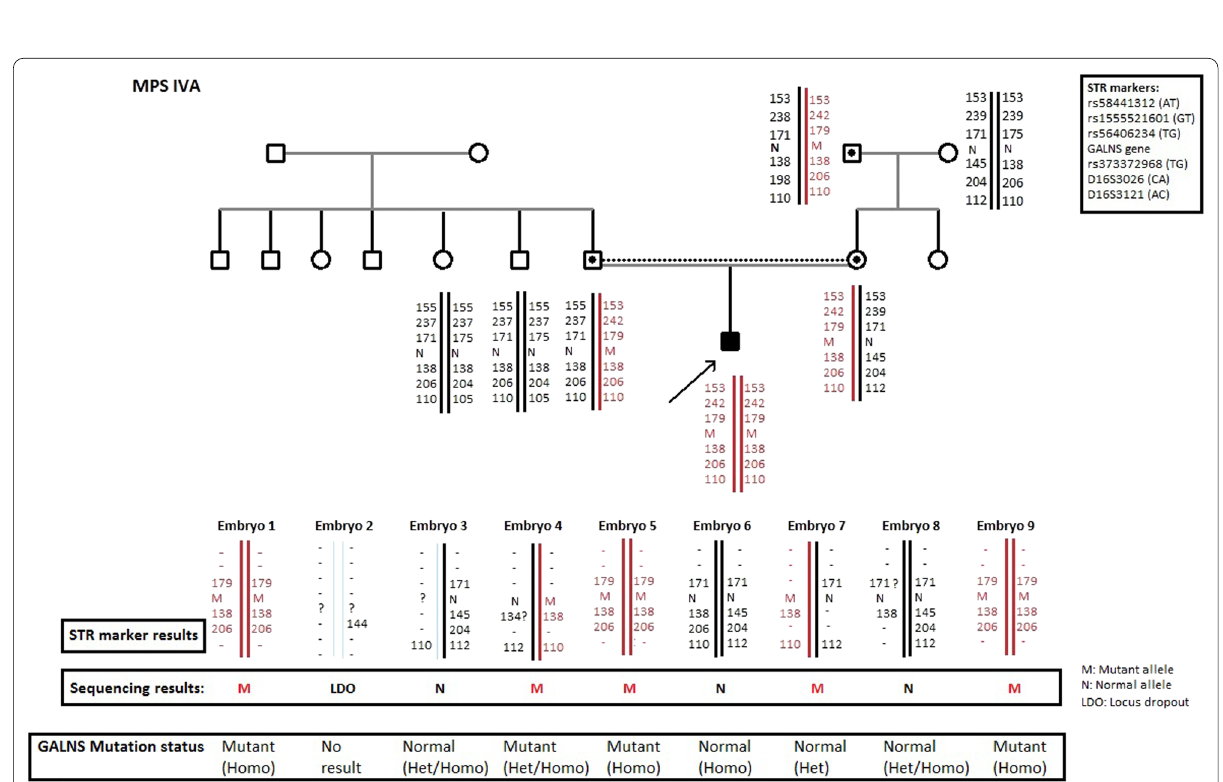
Fig. 2 Haplotype analysis for STR markers flanking the GALNS gene and sequencing results of GALNS